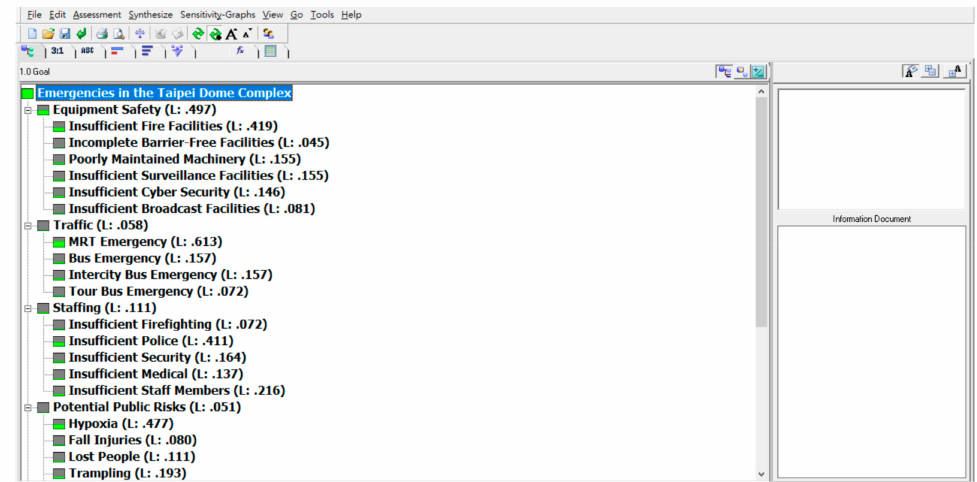
Figure 5. Expert Choice 11.0 user interface.